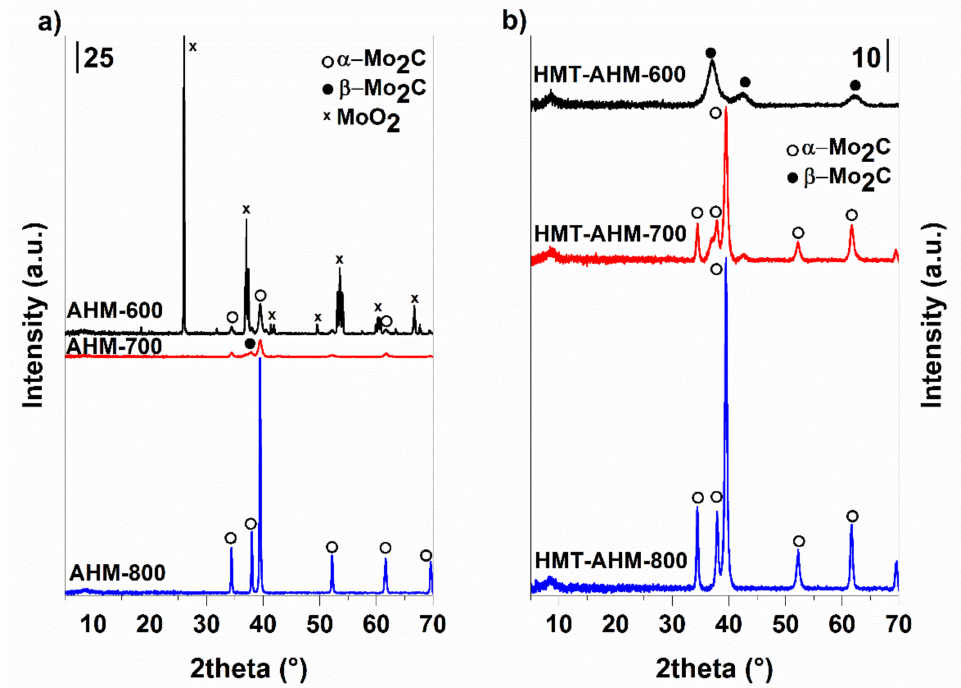
Figure 6. X-ray diffraction patterns of the molybdenum carbides prepared from AHM ( a ) and HMT-AHM ( b ) at 600–800 ◦